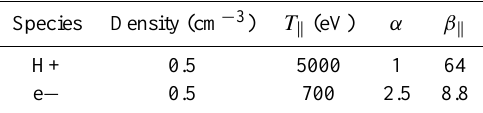
Table 2. Plasma model 2 corresponding to the period between 02:25 and 02:32UT with B 0 = 8nT.